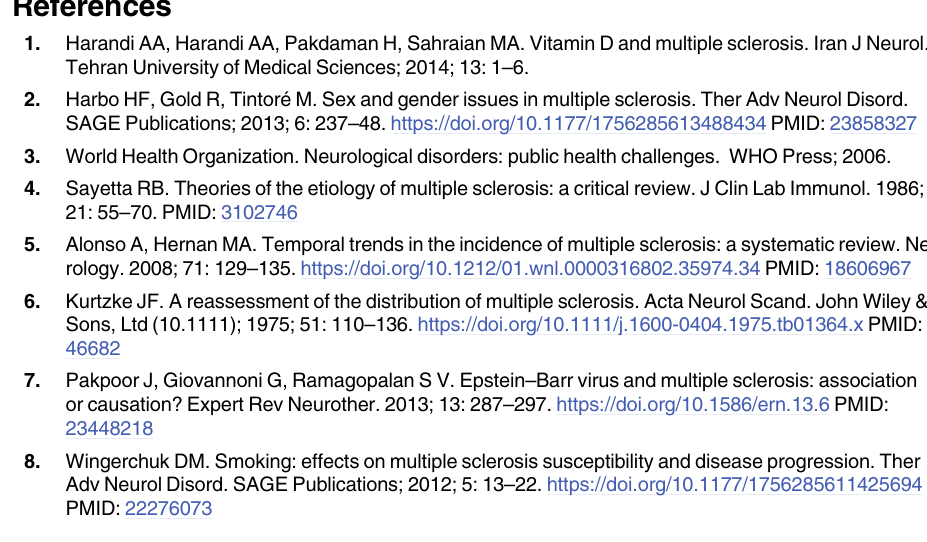
S2 Fig. The pooled estimates. Computed using the weights from the random effects meta- analysis. (PDF) S3 Fig. Study specific estimates and the pooled estimates in one plot. (PDF) S4 Fig. The study specific SIRs and CI’s. (PDF) S1 Table. Search strategy documentation. (PDF) S2 Table. Methodological quality of included studies. (PDF) S3 Table. Confounders (Population studies). (PDF) S4 Table. Confounders (The season or the month of birth studies).